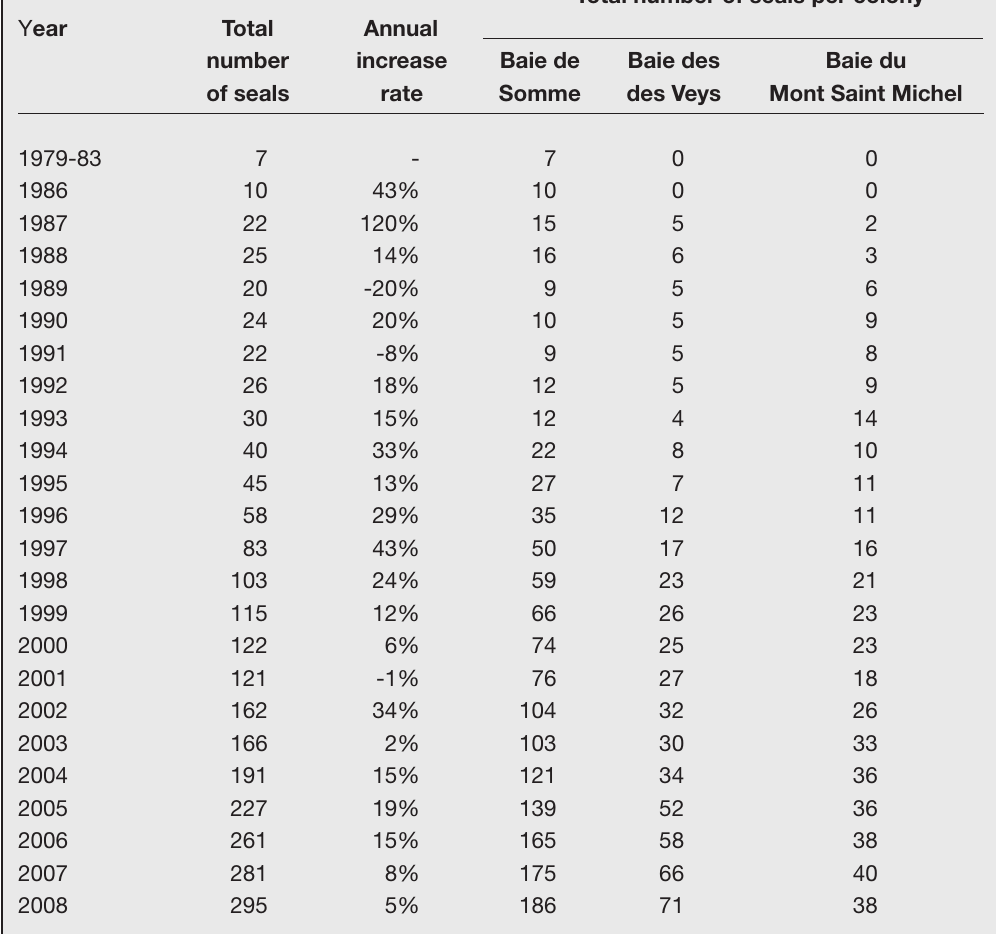
Table 1. Overview of the number of harbour seals at the three colonies, and annual total rate of